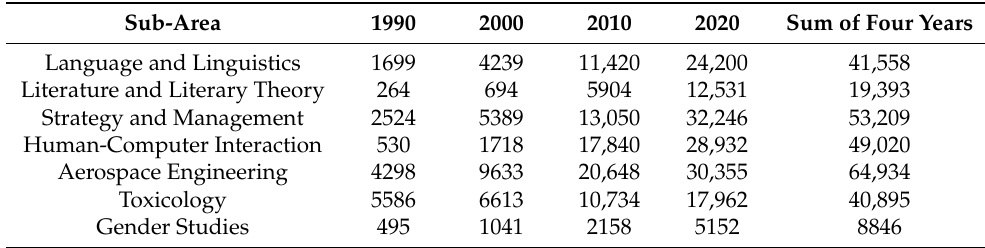
Table 1. Number of publications in the selected Scopus sub-areas by year. Sub-Area 1990